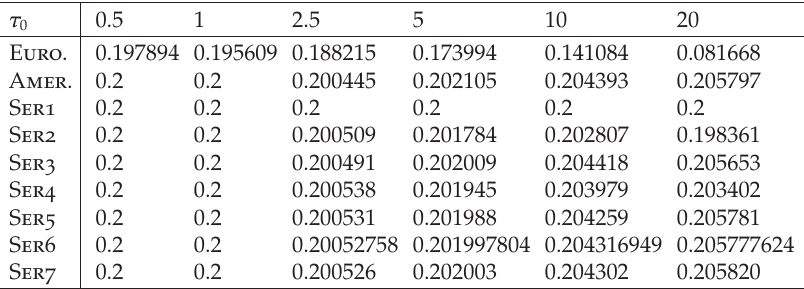
= 0 . 8, E = 0 . 6, r = 0 . 1,